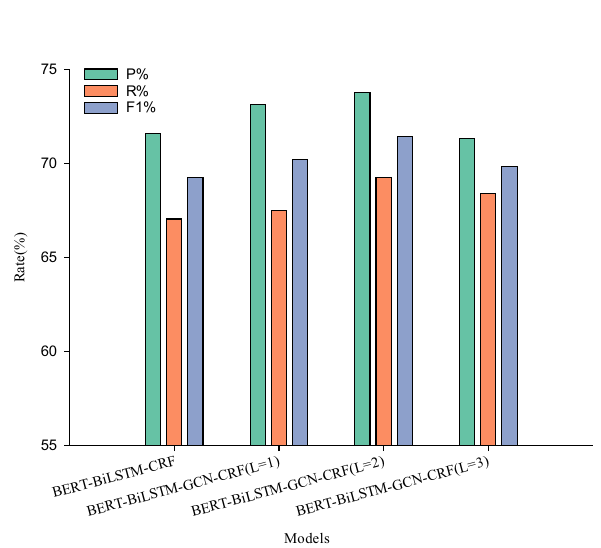
Fig. 6 Comparison of experimental results of different models